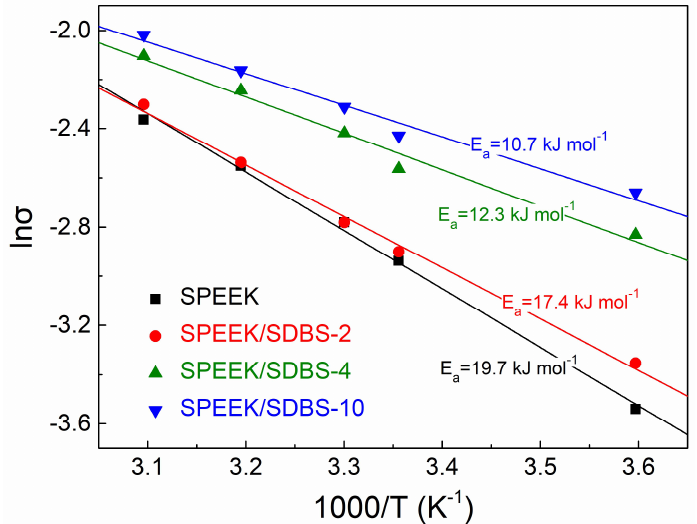
Figure 5. Arrhenius plots of proton conductivity for a SPEEK membrane and SPEEK/SDBS membranes with SDBS contents of 2 wt %, 4 wt %, and 10 wt % as a function of temperature.